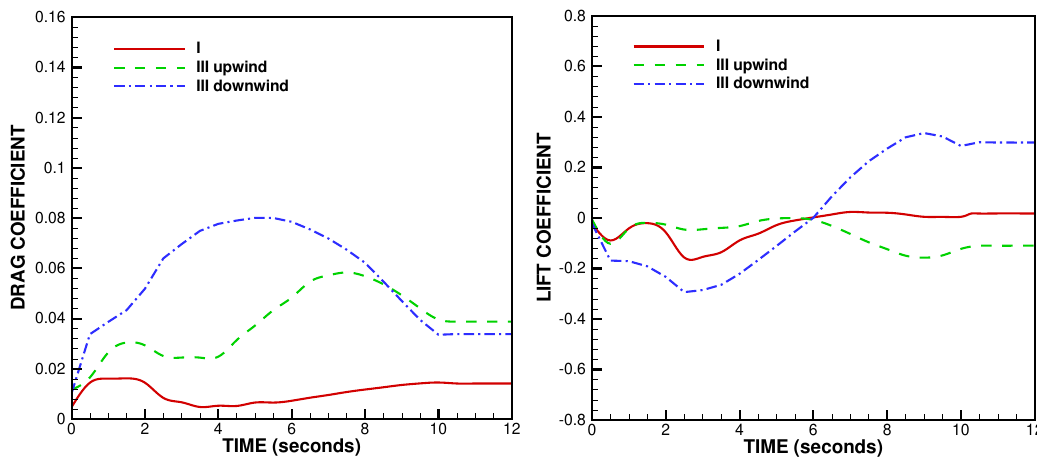
Figure 20. MLG: time history of drag and lift coefficients for the